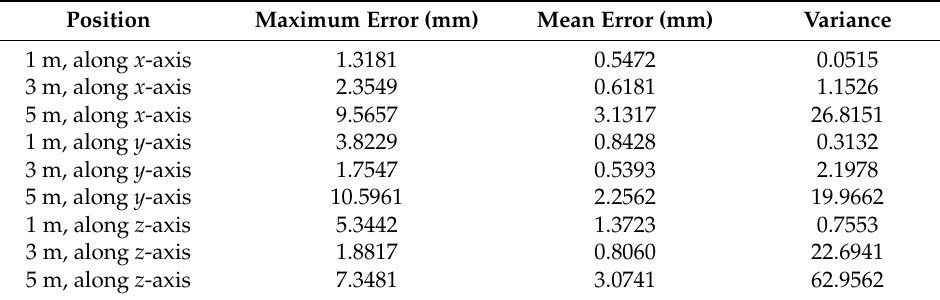
Table 1. The positional performance of our tracking system.